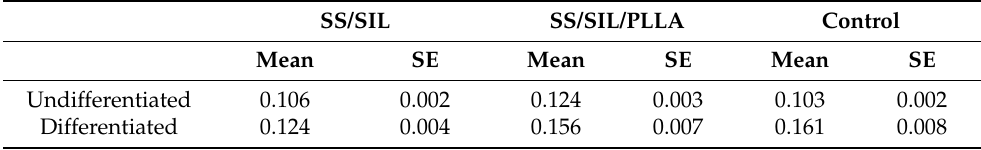
Figure 3. ARS semi-quantification in mM between groups (left panel). Results are presented in mean ± SE. Differences were considered statistically significant at p < 0.05. Results significance are presented through the symbol (*), according to the p -value, with one, two, three or four symbols, corresponding to 0.01 ≤ p < 0.05; 0.001 ≤ p < 0.01; 0.0001 ≤ p < 0.001; and p < 0.0001, respectively. The % mineral deposition enhancement normalized to the SS/SIL samples are presented in the right panel. Table 3. ARS semi-quantification in mM between groups. Results are presented in mean ± SE.